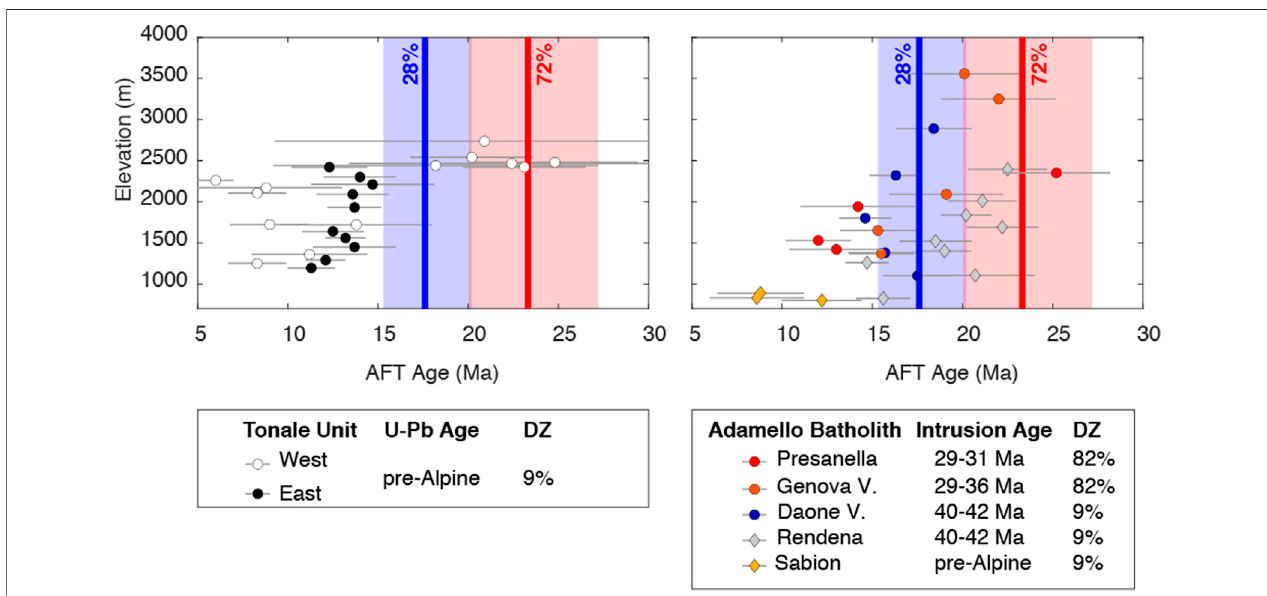
FIGURE9| DifferentAFTAge/Altitudepro fi lescomparedwiththetwoAFTpopulationsdetectedinthesedimentofRaponzoloCave(blue17.6 Ma,red23.3 Ma).In the lower boxes, each transect is correlated with the U-Pb age of zircons in each area. DZ shows to which percentage of ages the populations in the Raponzolo sample areassociated:agesbetween29and36 Ma(82%),agesbetween40 – 42(9%),pre-Alpineages(9%).AFTpro fi les:TonalefromMartinetal.(1998);PresanellafromViola et al. (2001); Genova and Daone valleys from Reverman et al. (2012); Rendena from Martin et al. (1998).